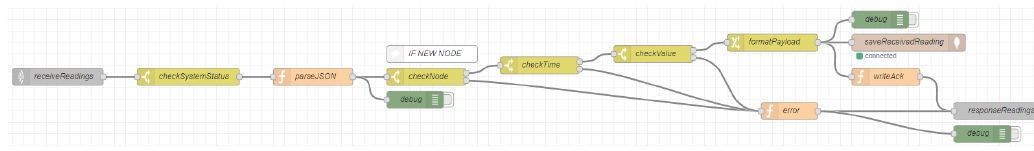
Figure 4. Reception